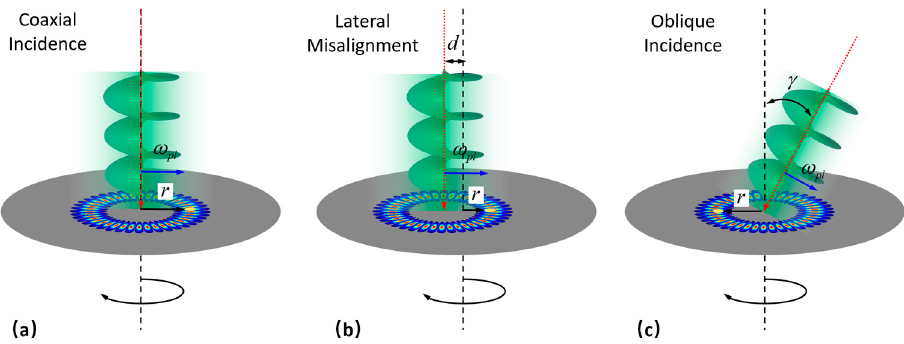
Figure 1. RDE detection under three different conditions: ( a ) OV illuminating the rotating object on the axis; ( b ) RDE detection under lateral misalignment; ( c ) RDE detection under light oblique incidence.